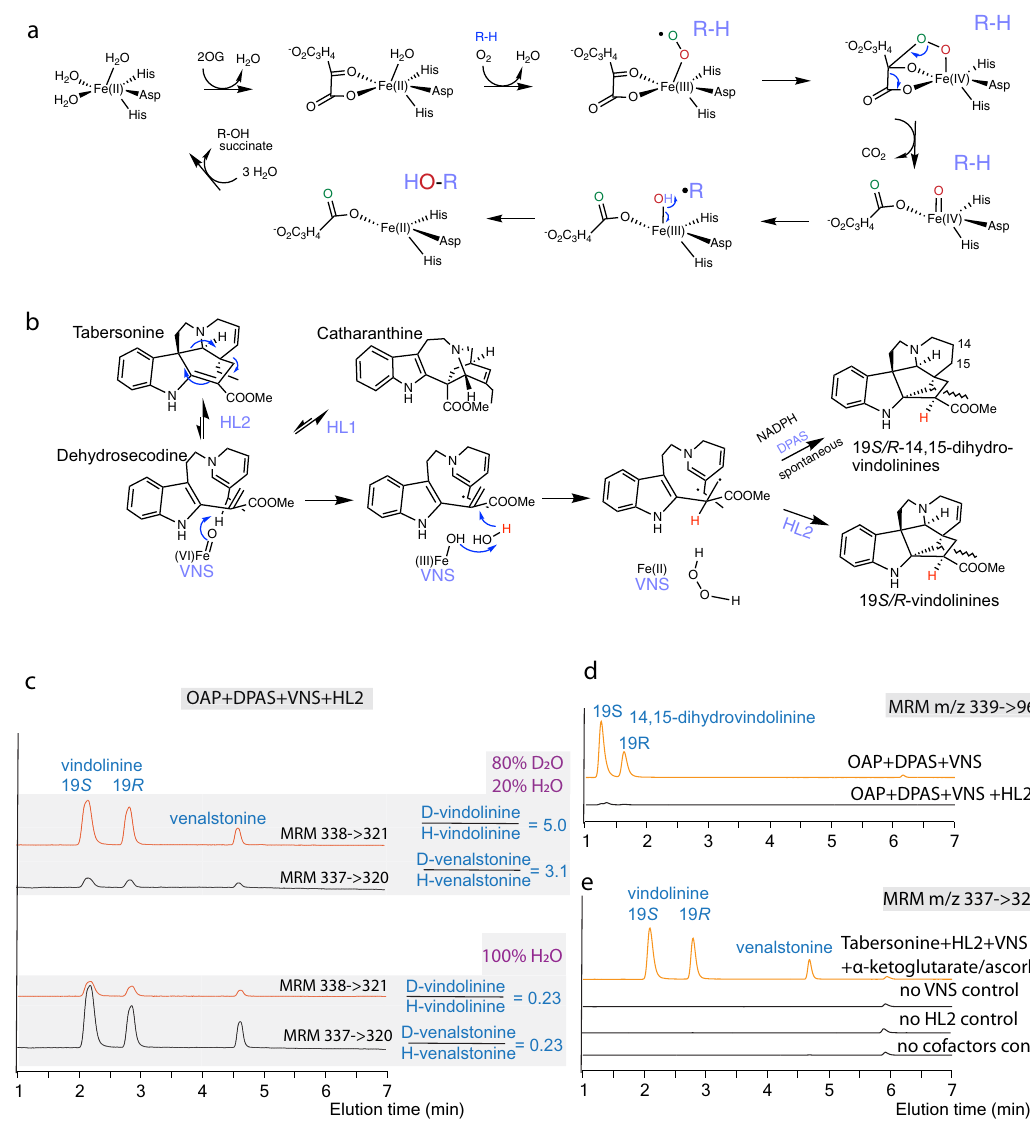
Fig. 3 Vindolinine synthase (VNS) catalyzes an unusual, redox neutral reaction with respect to the principal substrate dehydrosecodine and the product vindolinine epimers. a Typical reactions by Fe/2OG dioxygenases generate a substrate radical by enzyme-bound Fe(IV) = O, which rebounds with the hydroxyl radical leading to substrate hydroxylation. b Proposed VNS reaction involves the radical formation by Fe(IV) = O and water oxidation to regenerate Fe(II). The resulting di-radical is either cyclized by hydrolase 2 (HL2) to form the 19 S/R -vindolinines and venalstonine or spontaneously cyclizes with further reduction to form 19 S/R -14,15-dihydrovindolinines. c Replacing the reaction in 80% D 2 O resulted in the incorporation of one deuterium into the vindolinine/venalstonine structures as the m/z values were all increased by 1 amu. d In the absence of HL2, the reaction product was further reduced by DPAS and spontaneously cyclized to form 19 S/R -14,15-dihydrovindolinines. e HL2 catalyzed the reverse reaction to generate dehydrosecodine from tabersonine, which was catalyzed by VNS and HL2 in the forward reaction to generate 19 R /19 S -vindolinine epimers and venalstonine. The alkaloid MS spectra used for selecting MRM parameters are found in Supplementary fi gure 3 and Supplementary fi gure